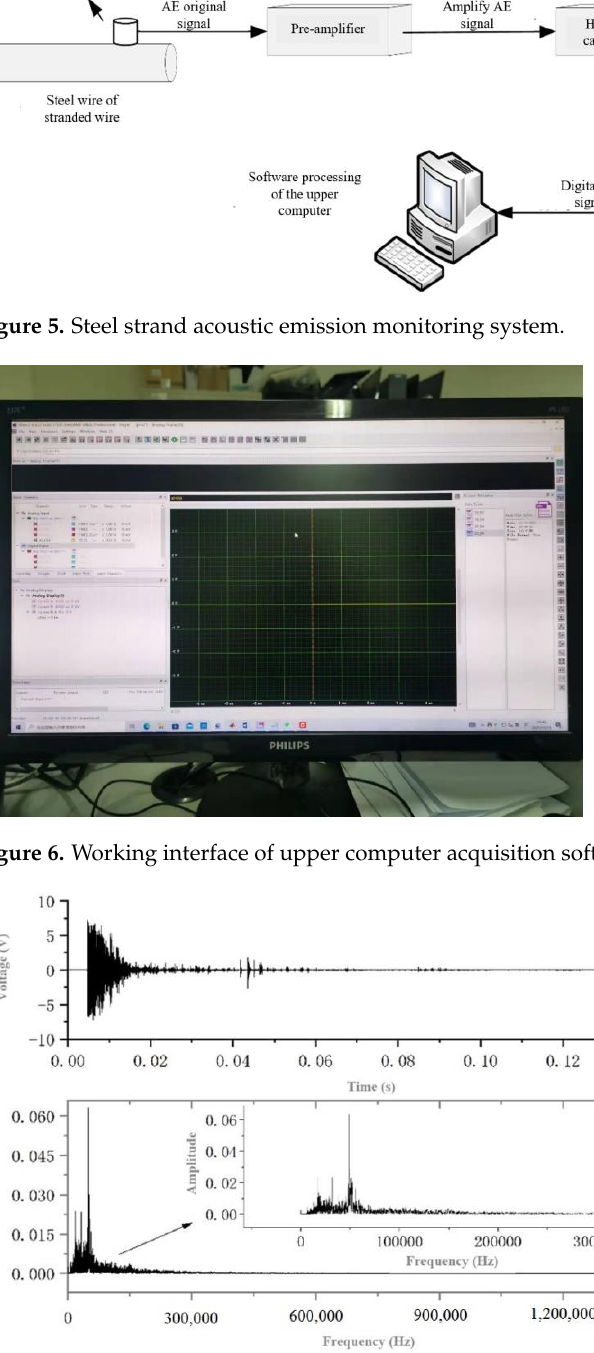
Figure 7. Spectrogram of broken wire acoustic emission signal.